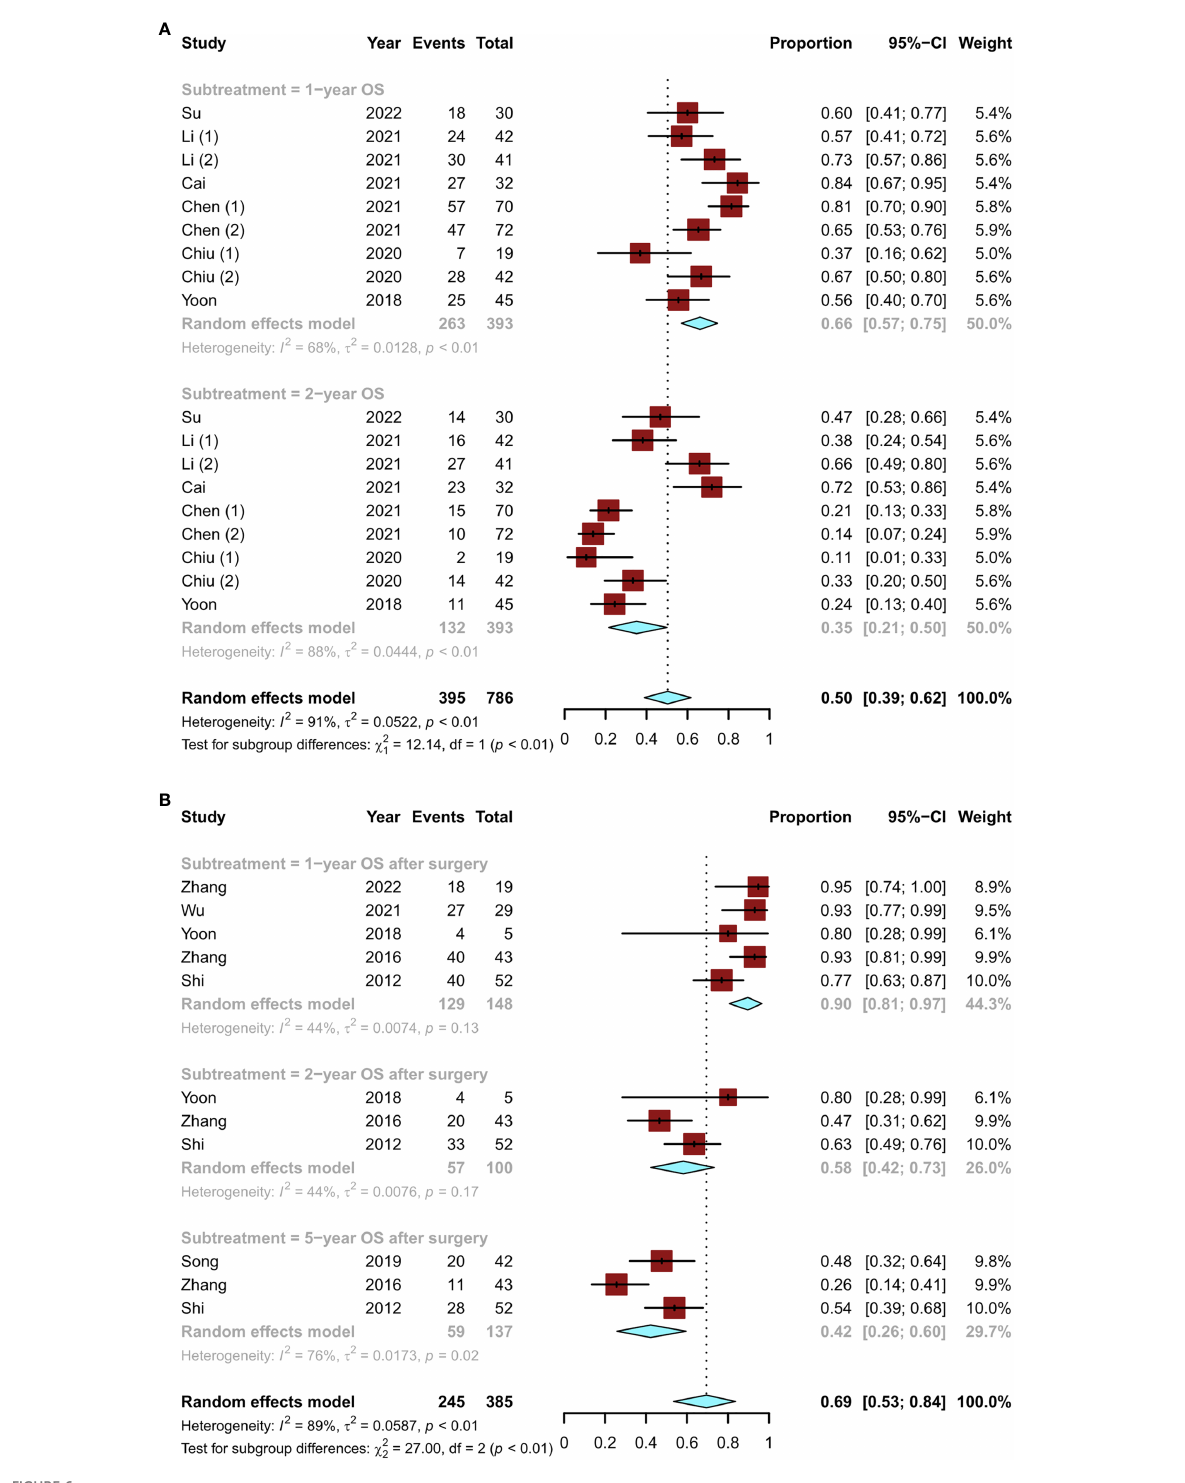
FIGURE 6 Details of the overall survival of patients who underwent conversion therapy, including the (A) overall survival of patients initially treated with conversion therapy and (B) postoperative overall survival in patients who underwent successful surgical resection after conversion